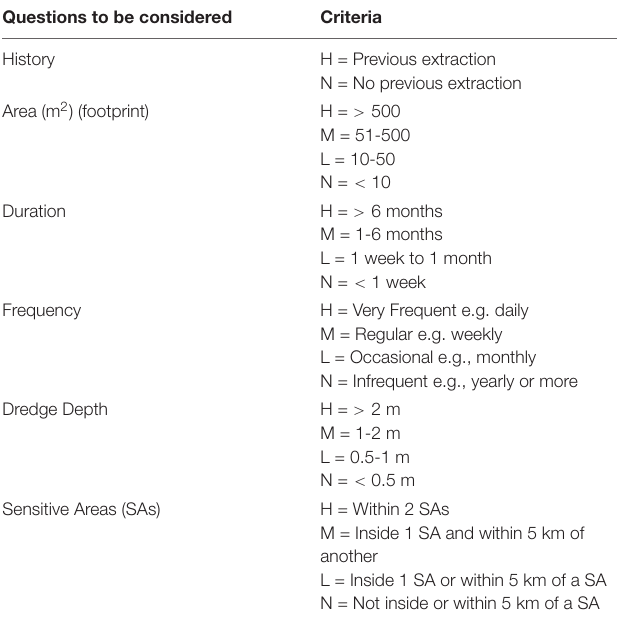
TABLE 1 | Questions and criteria to be considered when characterising an extraction activity. ‘H’ High risk; ‘M’ medium risk; ‘L’ low risk; ‘N’ negligible risk. Questions to be